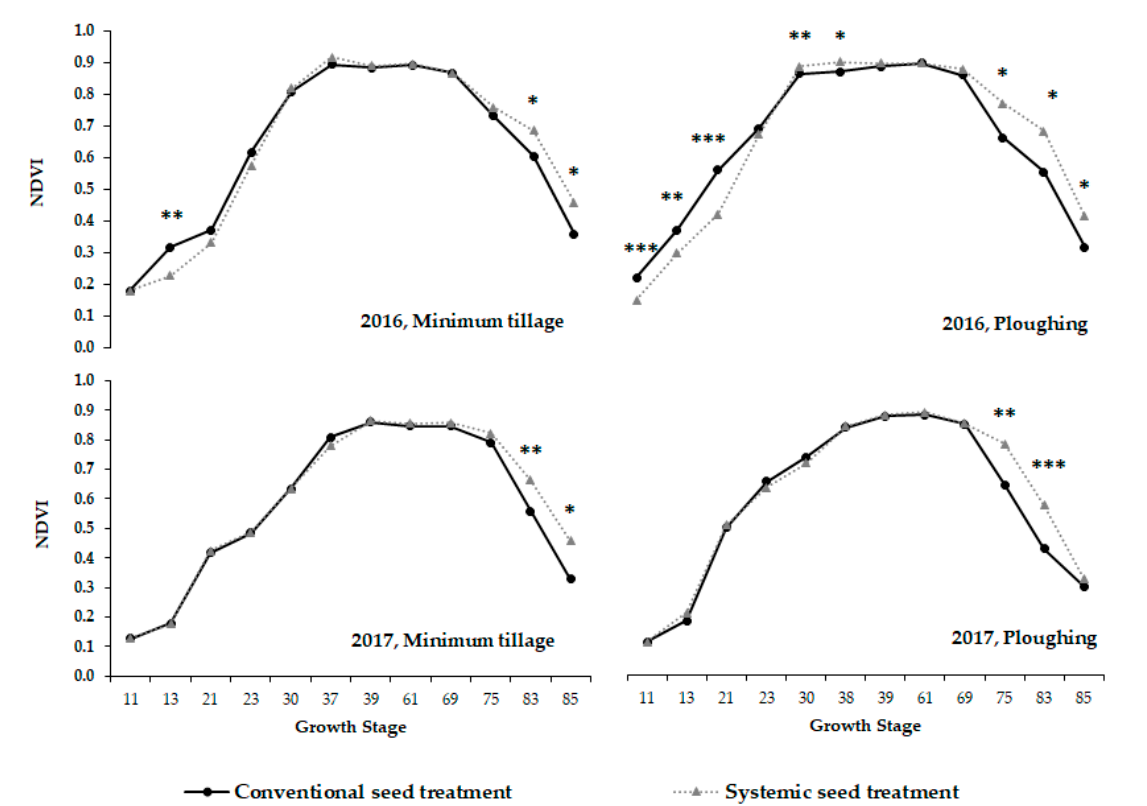
Figure 2. Effect of fungicide seed treatments 1 on the normalized difference vegetation index (NDVI) measured from the first unfolded wheat leaf (GS11) to the soft dough stage (GS85) in different soil tillage and growing seasons (2015–2016 and 2016–2017) in North-Italy. ANOVA was performed for each NDVI value: * significant difference at the <0.05 level; ** significant difference at the 0.01 level; *** significant difference at the <0.001 level. The reported data are based on four replications of the untreated control, without any foliar fungicide. 1 Fungicide seed treatments: conventional (fludioxonil AI) and systemic (fluxapyroxad AI).